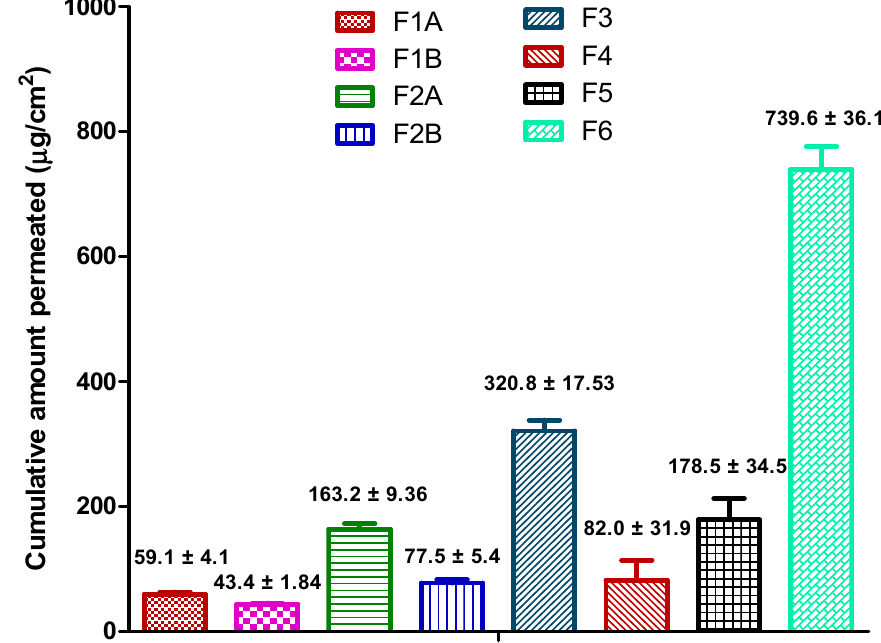
Figure 3. Cumulative amount of drug permeated from the formulations at the end of 24 h. Table 7. Cumulative amount, flux, and lag-time of drug permeated from the formulations at the end of 24 h (mean ± SD).